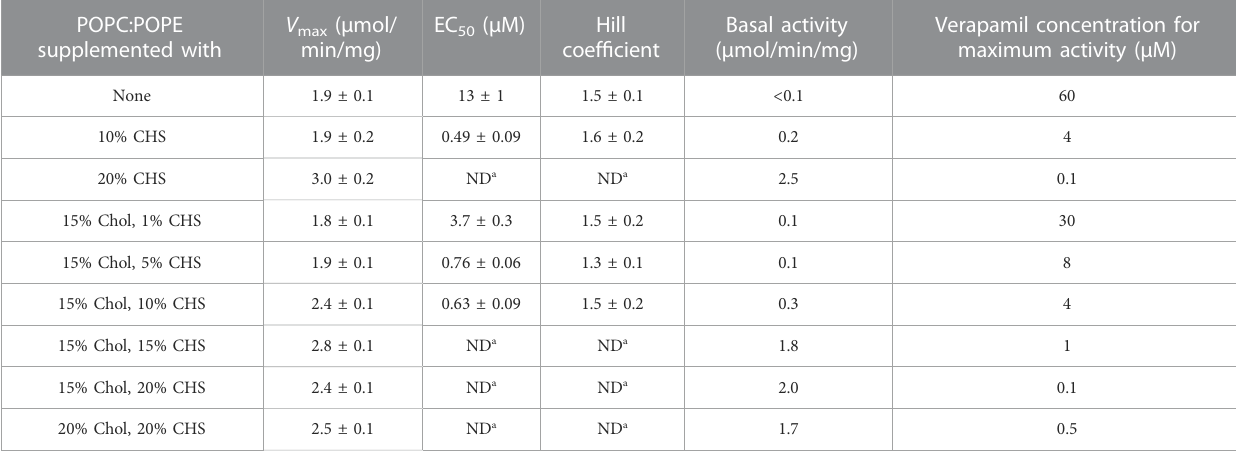
TABLE 4 POPC:POPE (50:50, w/w) was supplemented with the indicated concentrations of cholesterol and CHS and the verapamil stimulation of ATPase activity was assayed ( n = 3). POPC:POPE supplemented with